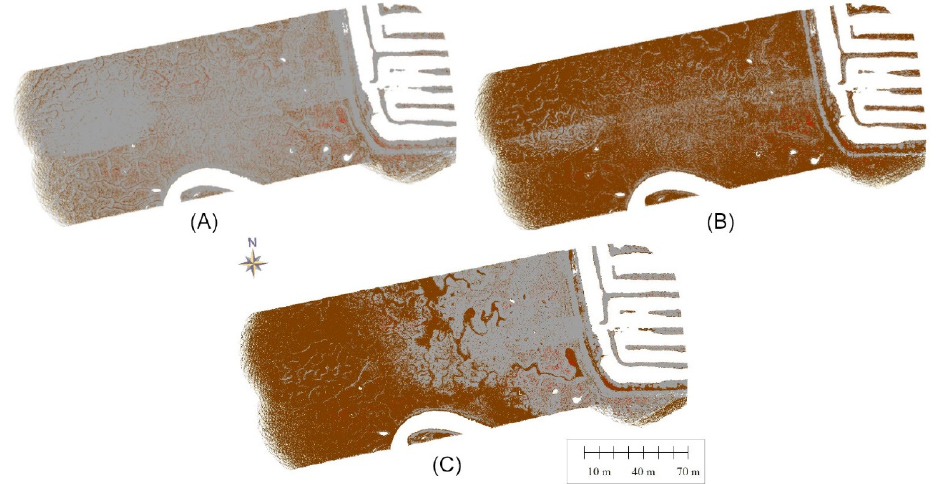
Figure 7. Approaches for LiDAR point cloud classification. ( A ) Classification after the application of the non-ground threshold of 0.03 m. ( B ) Classification after the application of the non-ground threshold of 0.10 m. ( C ) Classification after the introduction of multispectral data. Brown and grey points represent ‘ground’ and ‘never classified’ classes (i.e., vegetation), respectively. Red points are noise.